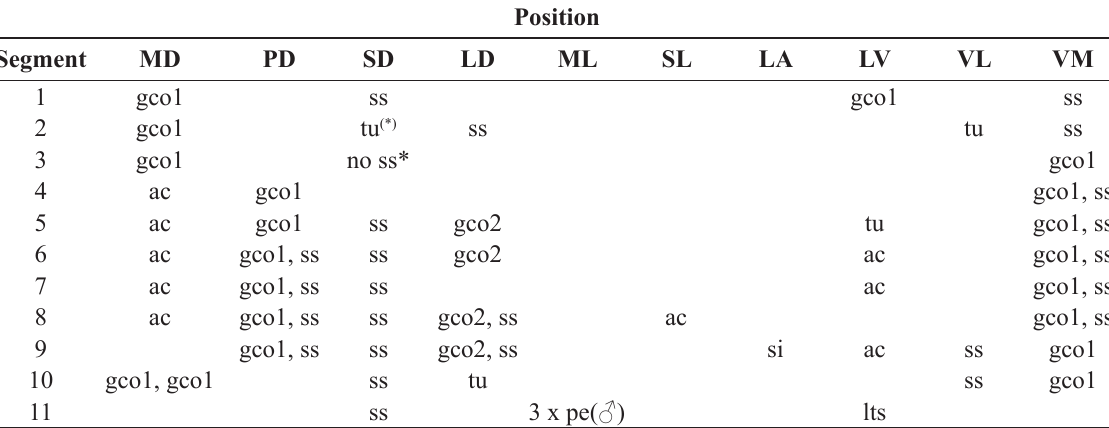
Table 18. Summary of nature and location of sensory spots, glandular cell outlets, tubes and spines arranged by series in Fissuroderes higginsi . Abbreviations: LA = lateral accessory; LD = laterodorsal; LV = lateroventral; MD = middorsal; ML = midlateral; PD = paradorsal; SD = subdorsal; SL = sublateral; VL = ventrolateral; VM = ventromedial; ac = acicular spine; gco1/2 = glandular cell outlet type 1/2; lts = lateral terminal spine; pe = penile spines; si = sieve plate; ss = sensory spot; tu = tube; ( ♂ ) = male condition of sexually dimorphic characters; * = marks characters differing in presence/absence from the original species description of Neuhaus & Blasche (2006); (*) = marks characters also present in the original species description of Neuhaus & Blasche (2006), but in a slightly different